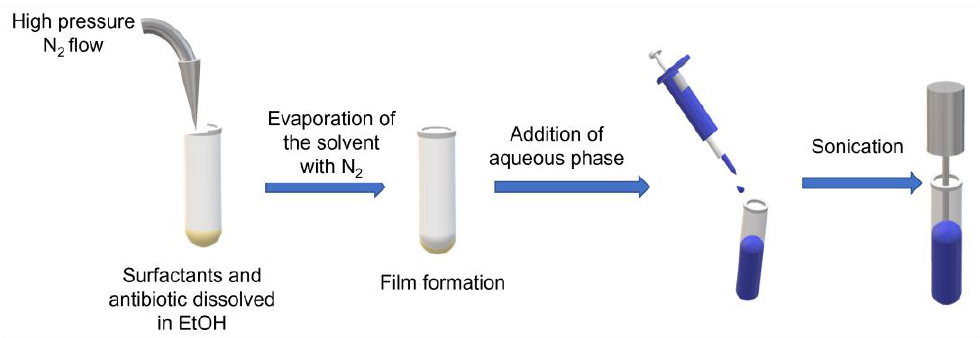
Figure 1. Thin film hydration method at small scale.